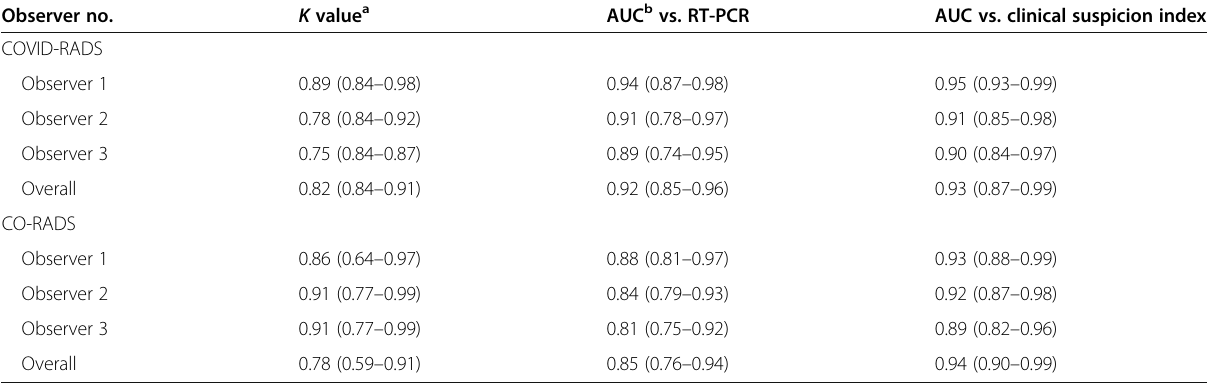
Table 3 Interobserver reliability and performance Observer